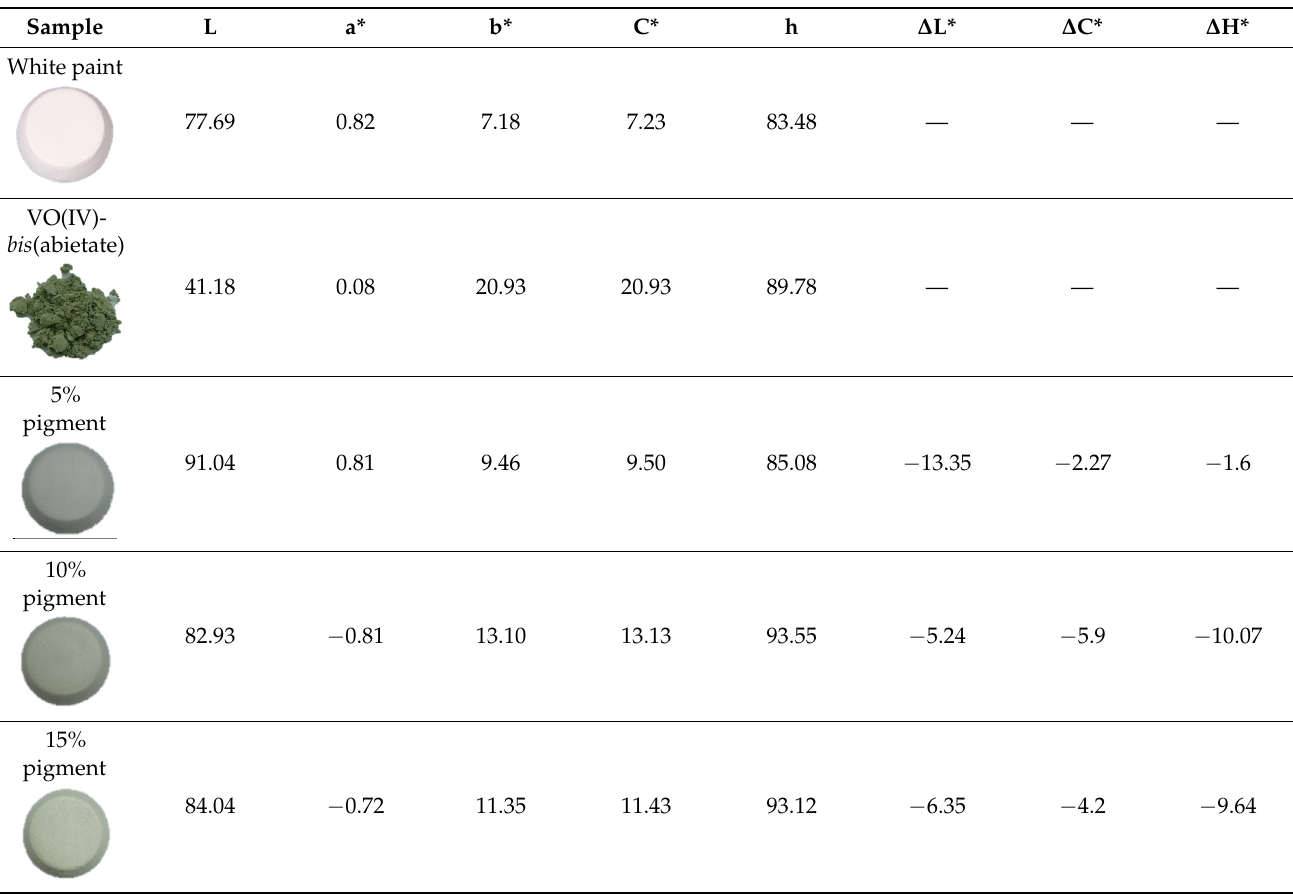
Figure 7. CIELAB color space graph for VO(IV)- bis (abietate) in powder form and dispersed in com- mercial white paint. Table 2. Colorimetric data of powdered and dispersed VO(IV)- bis (abietate) in paint.